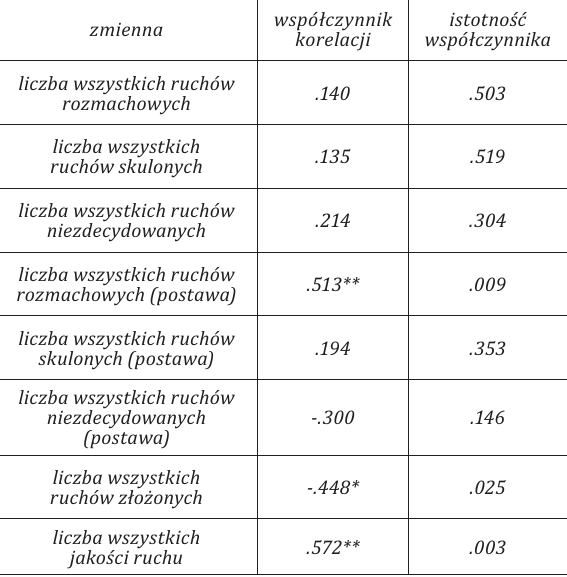
Tabela 8. Wartości rho Spearmana między zmienną „światłocienie” a zmiennymi dotyczącymi jakości